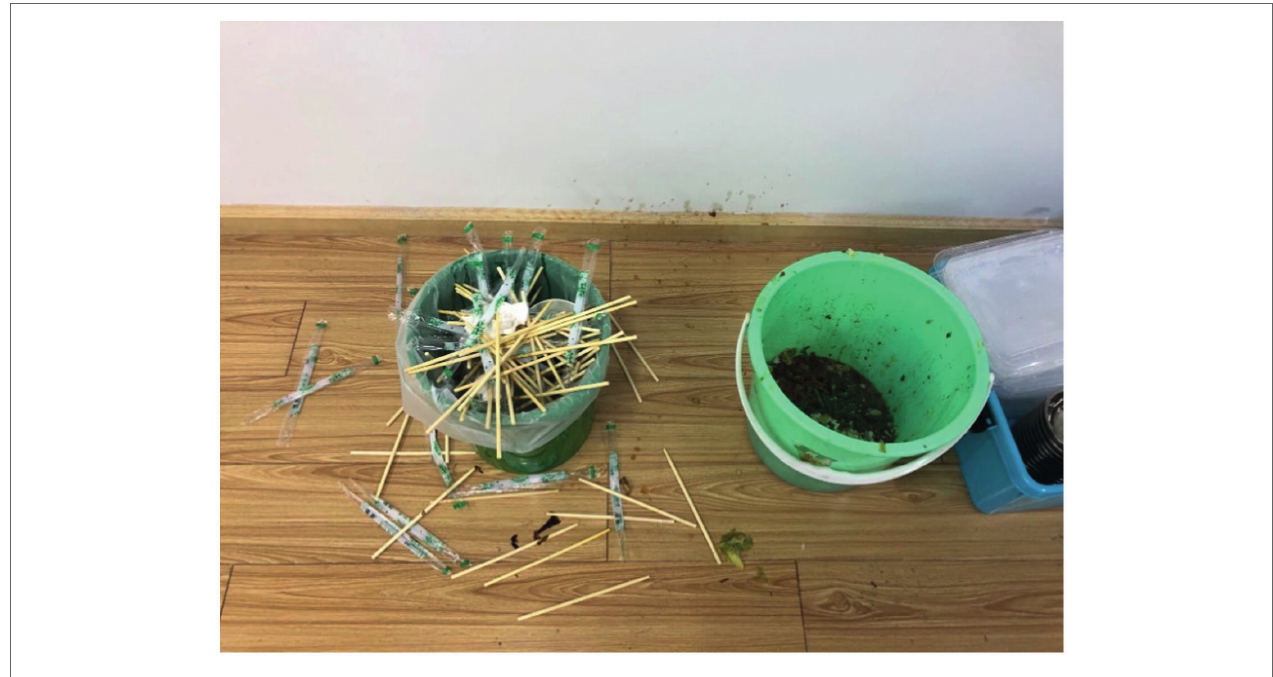
FIGURE 1 | The designated garbage disposal area.